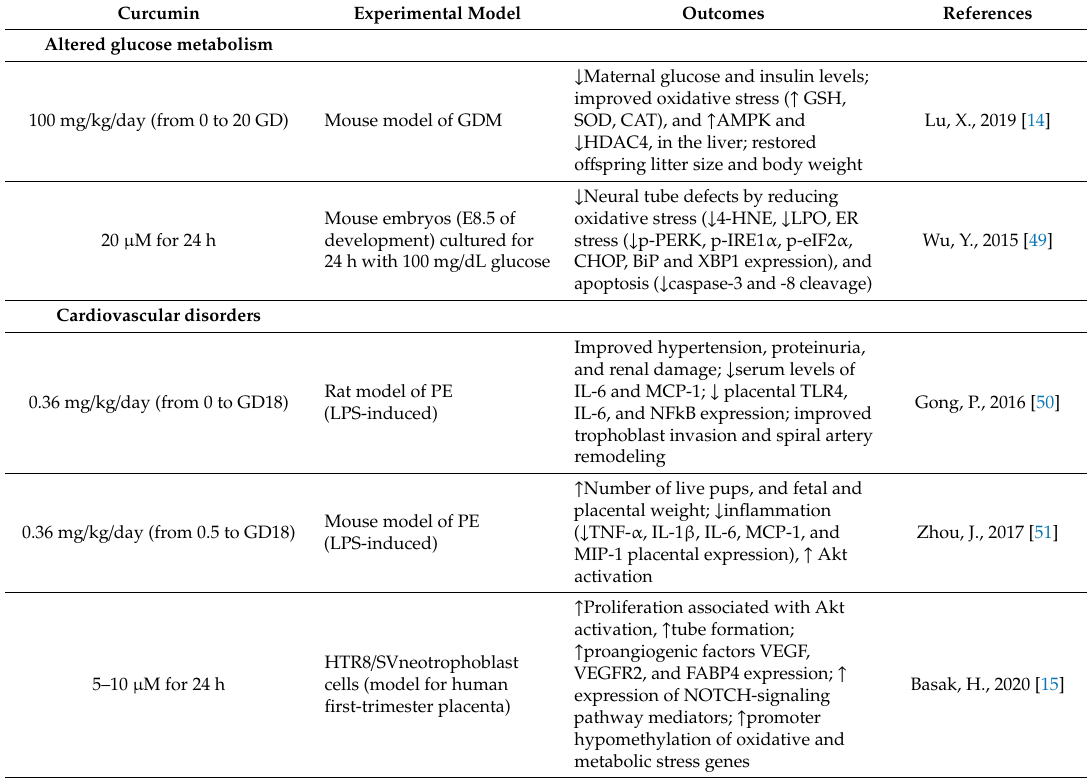
Table 1. E ff ects of curcumin on pregnancy and pregnancy-related